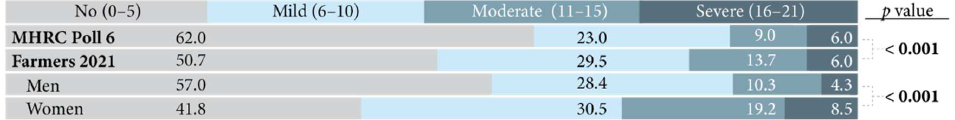
a Statistical comparison within 2021 data. b Statistical comparison of 2021 data with Canadian gen- eral population in Spring 2021. c Statistical comparison of 2021 data with Canadian general popula- tion in Fall 2020.